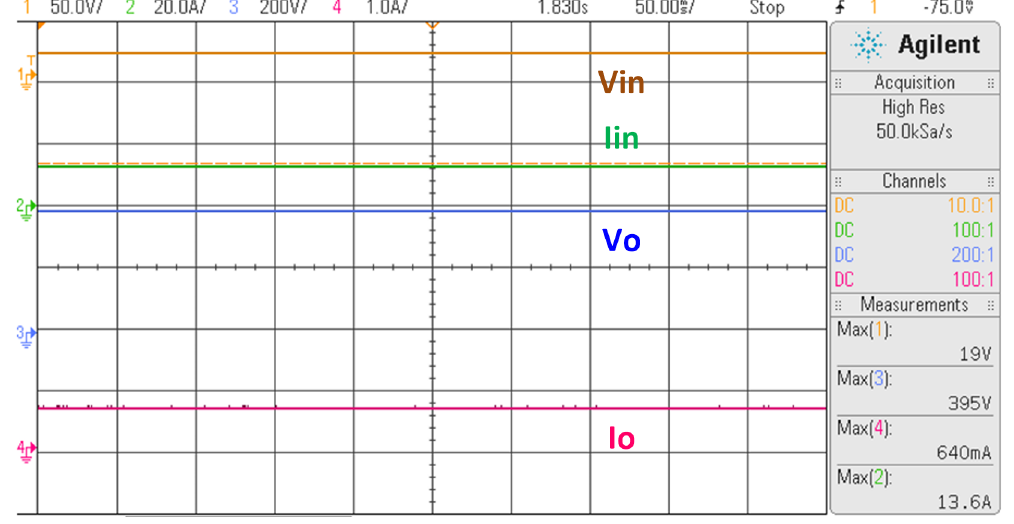
Figure 17. Input-Output voltage and current waveforms: Brown— V in , Green— I in , Blue— V o , Violet— I o